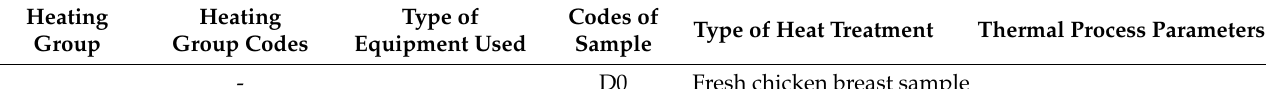
Table 1. A list of the type of heat treatments, heating groups, equipment and parameters, and coding